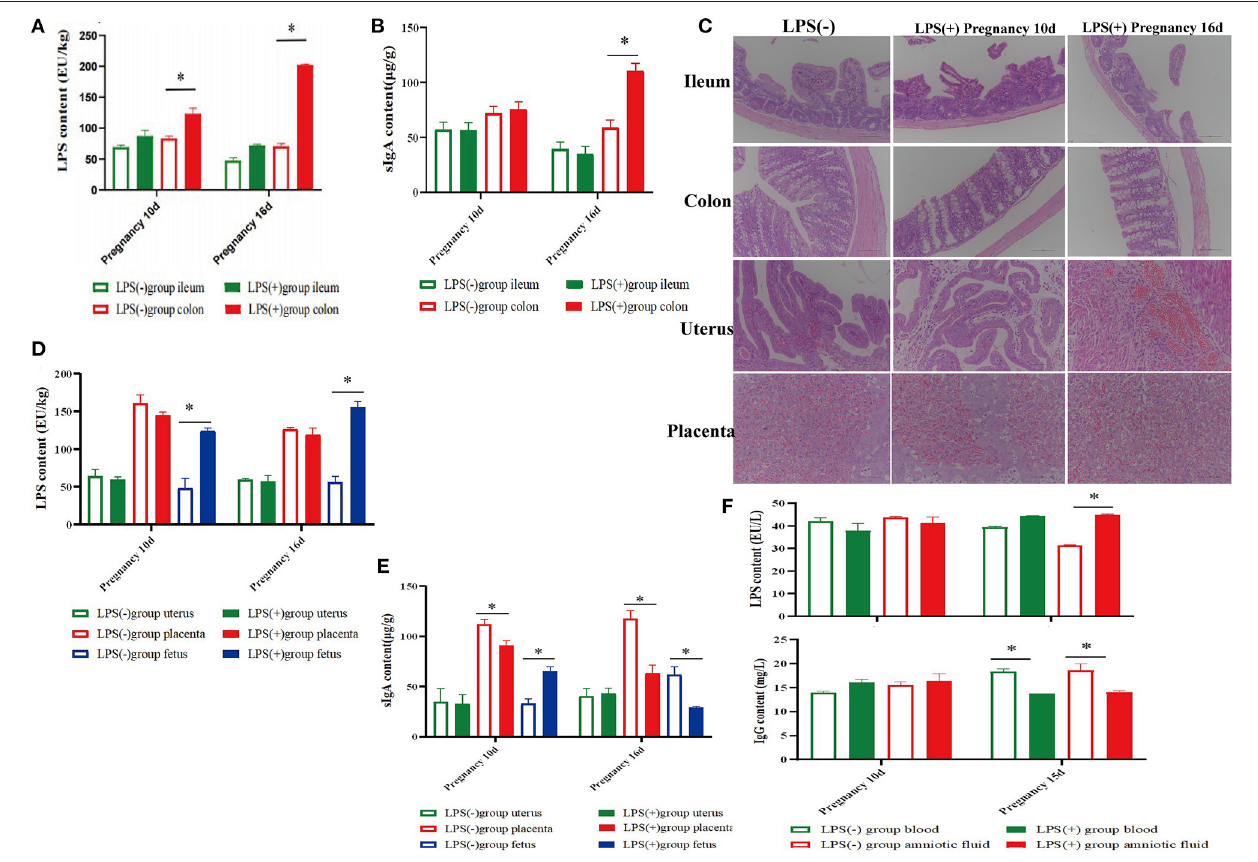
FIGURE 2 | Effect of LPS on histomorphology and biochemical indices during pregnancy in mice. (A) Content of LPS in ileum and colon tissues of mice at 10 and 16 days of pregnancy. (B) Content of SIgA in ileum and colon tissues of mice at 10 and 16 days of pregnancy. (C) Histomorphological changes in the ileum, colon, uterus, and placenta of mice at 10 and 16 days of pregnancy. (D) Content of LPS in the uterus, placenta, and fetus of mice at 10 and 16 days of pregnancy. (E) Content of SIgA in the uterus, placenta, and fetus of mice at 10 and 16 days of pregnancy. (F) Contents of LPS and IgG in the blood and amniotic fluid of mice at 10 and 16 days of pregnancy. * p < 0.05 indicates a significant difference between the LPS( + ) group and the LPS( − ) group during the same